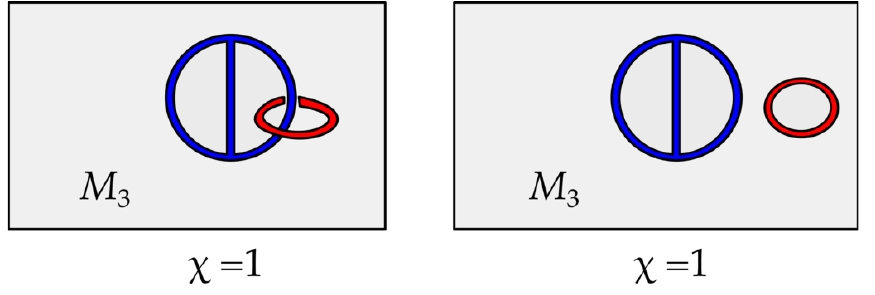
denotes the negative boundary of M 3 with respect Q ) = b 2 ( M 3 ; (cid:6) (cid:6) ). Q Q